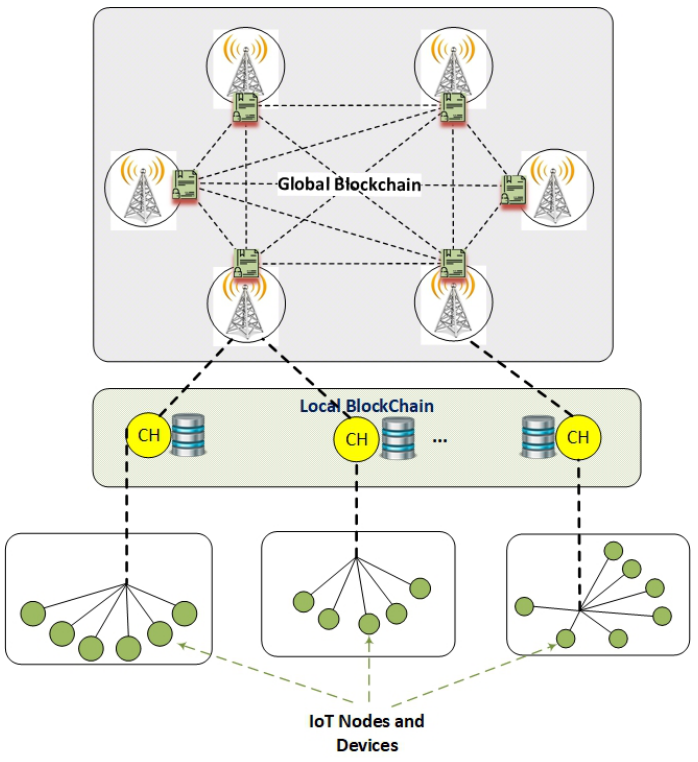
Figure 2. The network model based on a multi-layer structure that implements a local authorization service in the infrastructure level, a local blockchain, and public chain in the remaining two